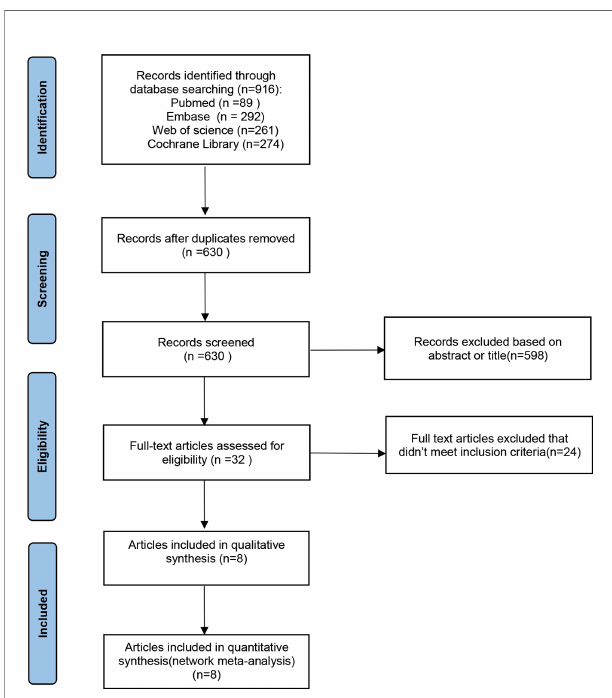
FIGURE 1 | The fl ow diagram of the study selection process.